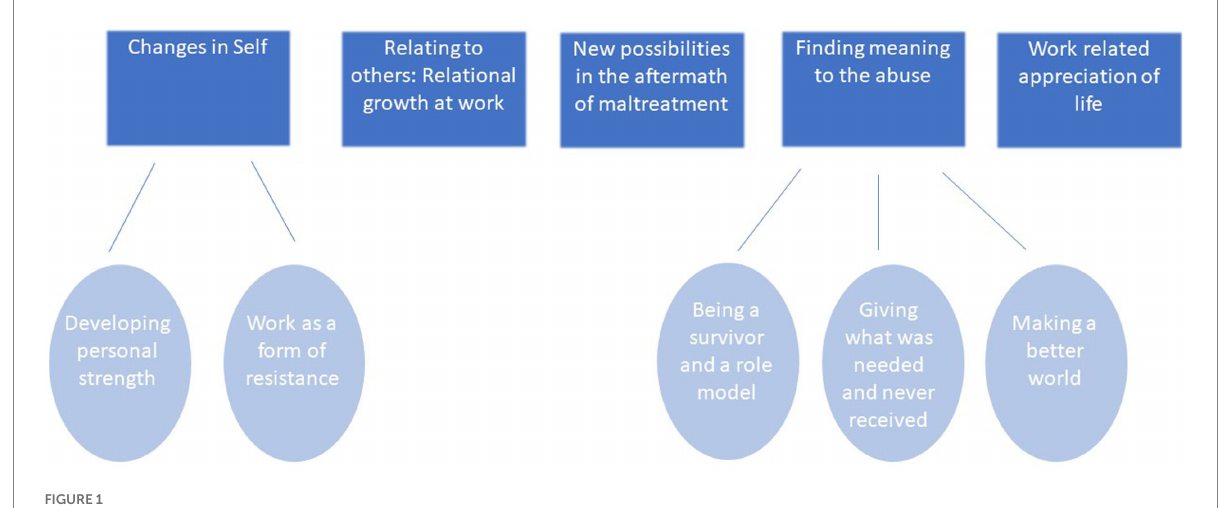
FIGURE 1 Five domains of work-related post-traumatic growth as described by